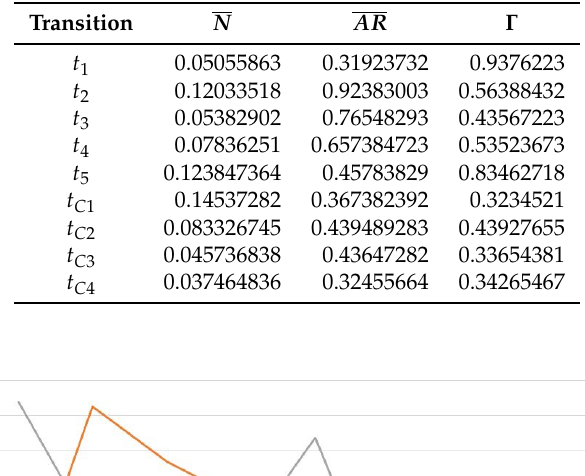
Table 2. Performance parameter.